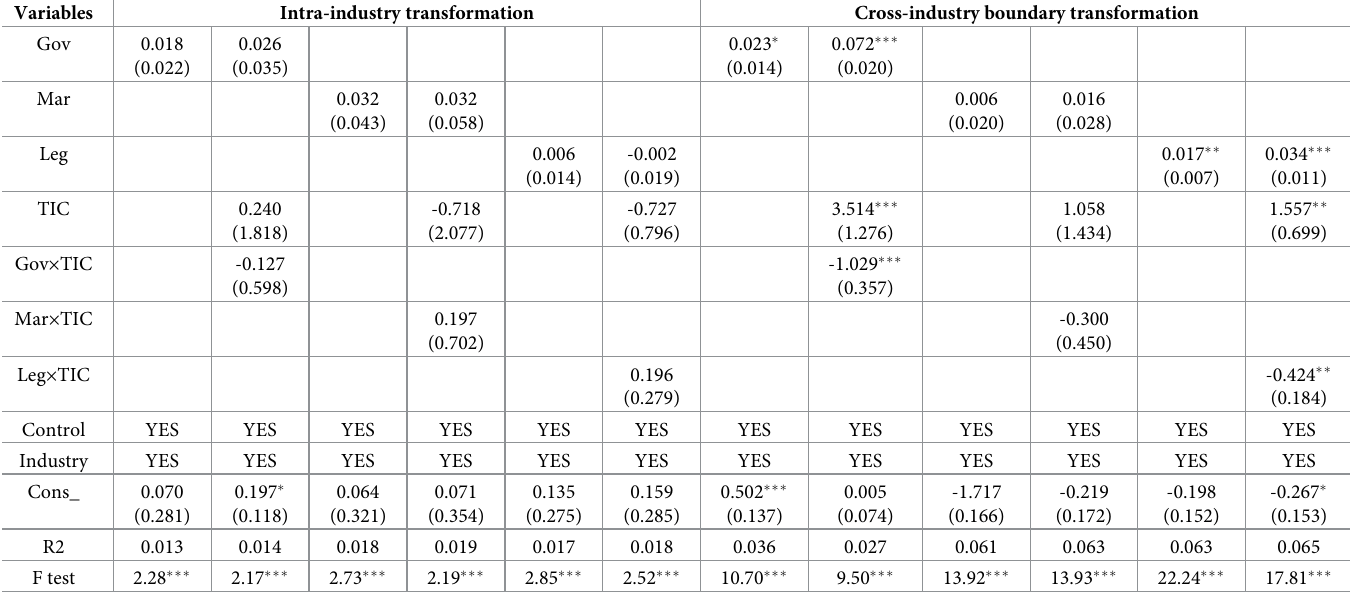
Table 7. Heterogeneity in the transformation of inter-industry boundaries of different property enterprises.